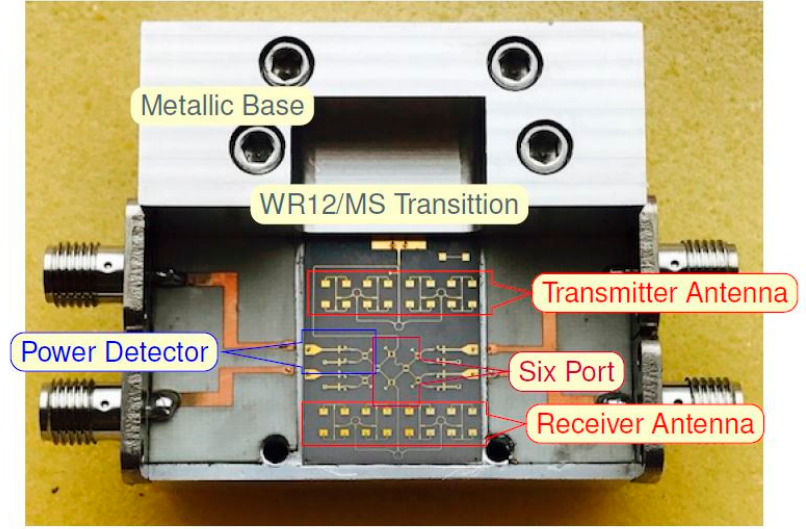
Figure 9. E-band multi-port radar sensor in aluminum fixture with standard WR-12 flange and SMA connectors.